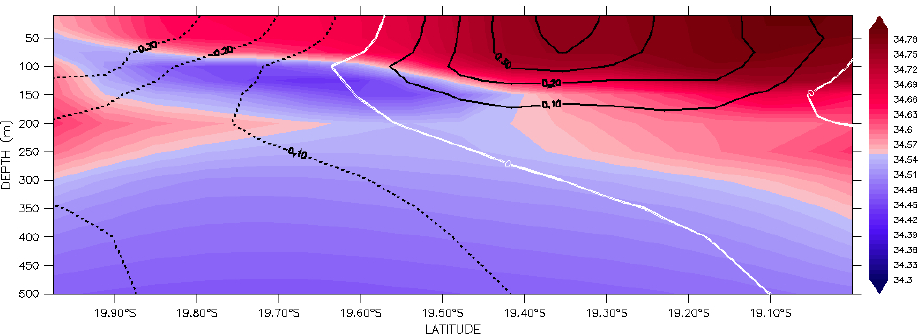
Fig. 14. Zonal velocities (ms − 1 ) of eddy at 76 ◦ W on the same day 10 November with the color contours showing salinity (psu). The positive velocities are shown as continuous lines and the negative values as dashed line contours. The cross-section is from 20 ◦ S to 19 ◦ S.